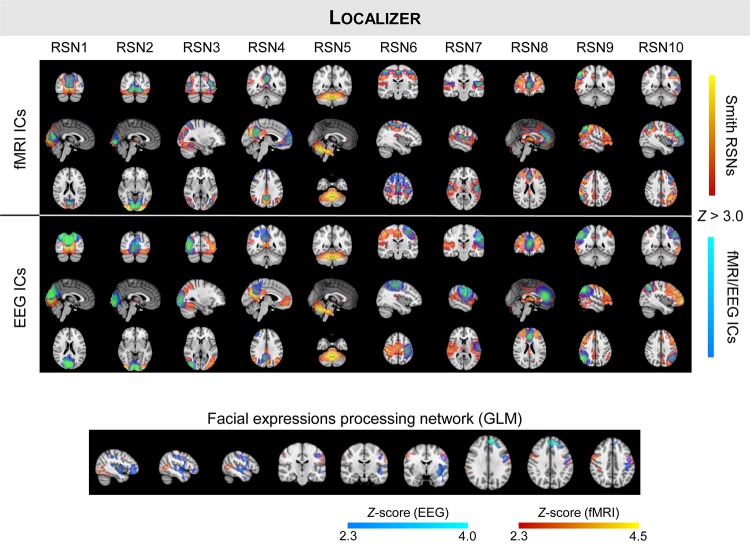
Same as in Figure 1, but showing the group RSNs identified on fMRI and EEG-ESI data for the localizer run. The group activation maps of the task-specific facial expressions processing network using fMRI (in red–yellow) and EEG (in blue–light blue) are also shown at the bottom, with the overlapping regions highlighted in pink.